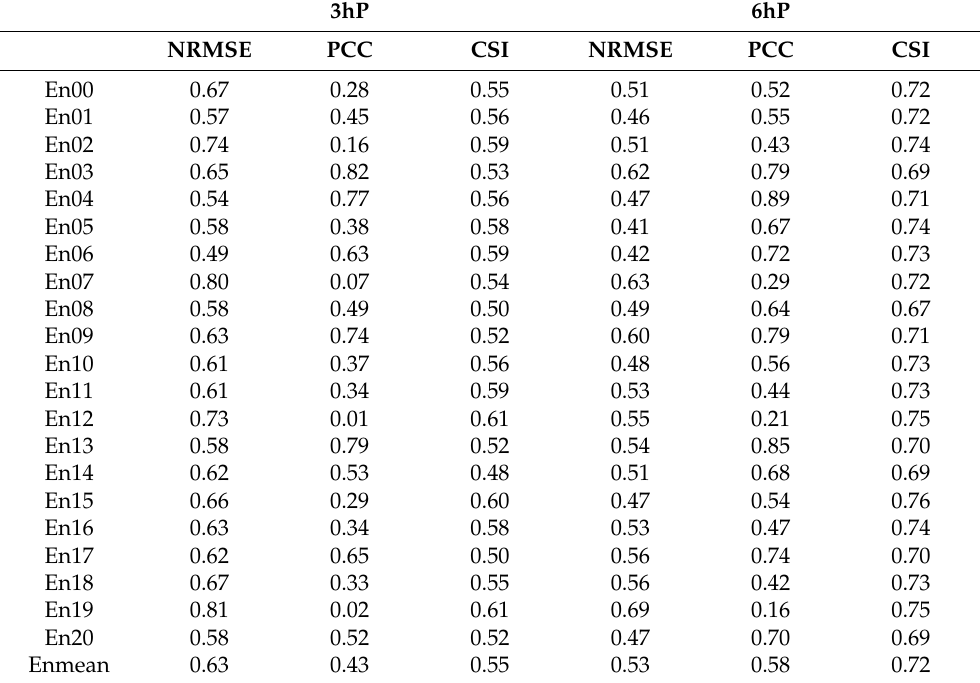
Table 4. Evaluation of 3hP and 6hP for all WRF